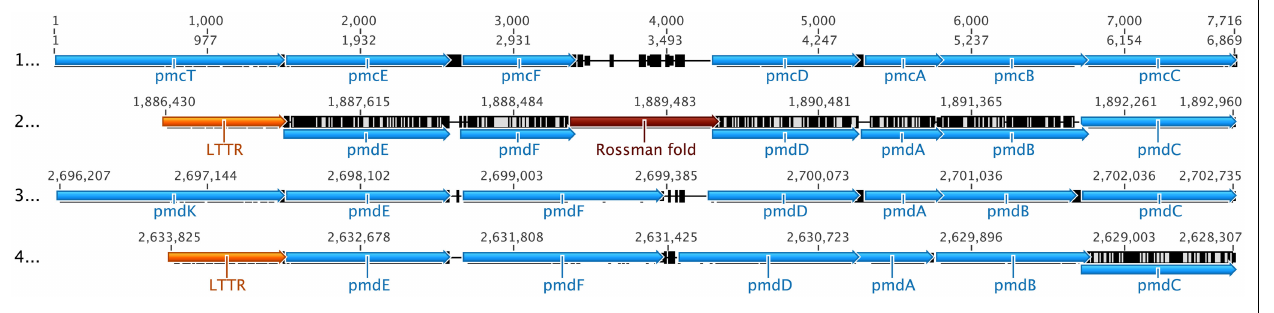
FIGURE 6 |Alignment of pmd/pmc clusters. Sequences are from: (1) Comamonas sp. DJ-12 (AY866410), (2) Delftia sp. Cs1-4 Cluster 1 (NC_015563), (3) Delftia sp. Cs1-4 Cluster 2 (NC_015563), (4) Ramlibacter tataouinensis TTB310 (CP000245).Values across the top of the diagram indicate position (bp) within the alignment, while those above each sequence